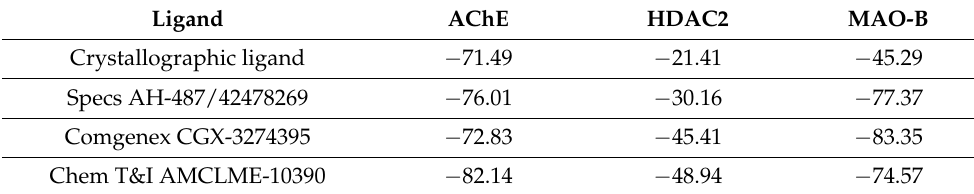
Table 5. Binding energies of the protein-ligand complexes from the MD simulations (kcal/mol). Ligand AChE HDAC2 MAO-B Crystallographic ligand −